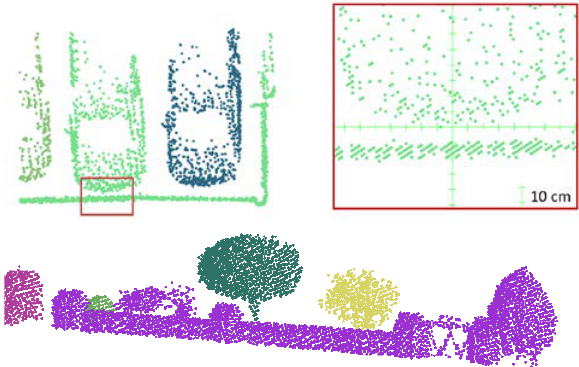
Figure 7 Segmentation errors still remain: fences cause that objects are still grouped together.